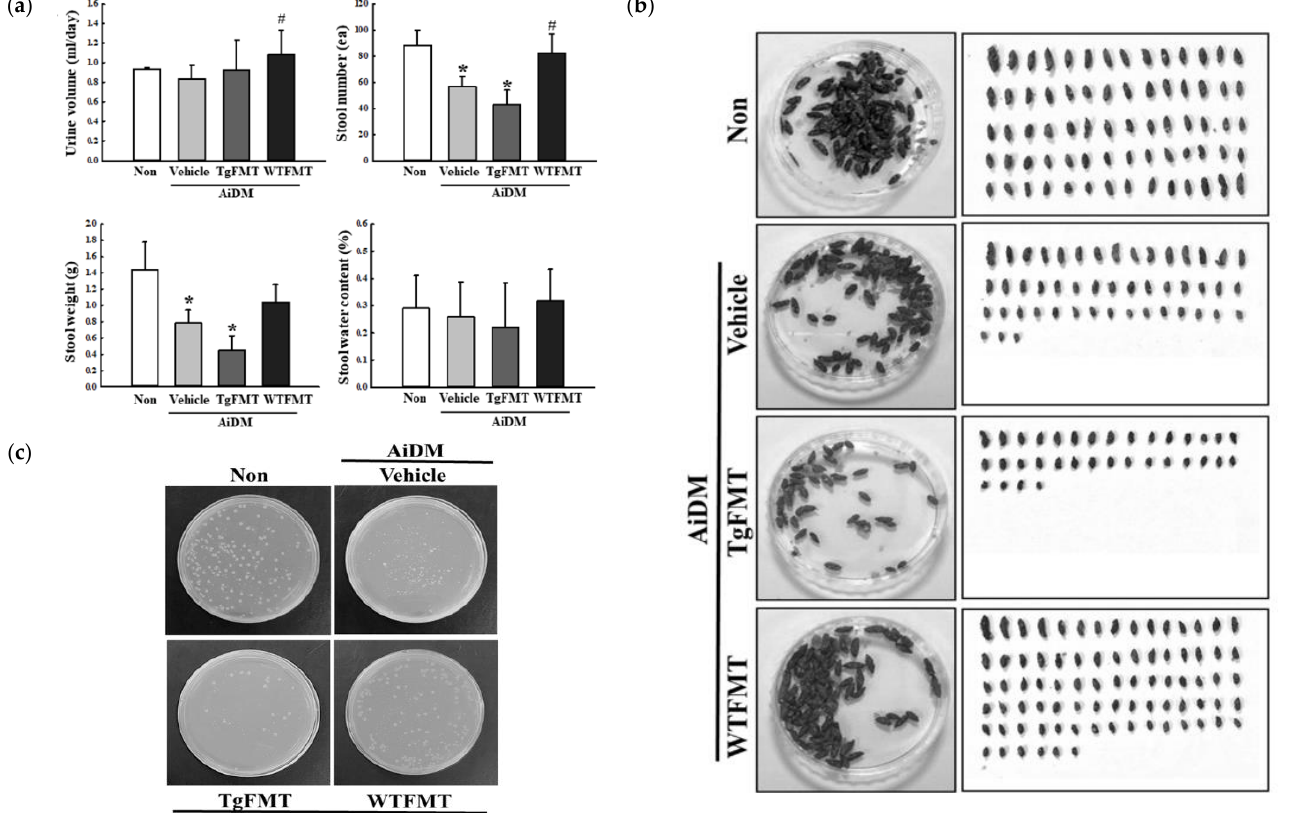
Figure 5. Excretion parameters and growth of feces-derived bacteria in AiDM+TgFMT mice. ( a ) Excretion parameters. The urine volume, stool number, stool weight, and stool water contents were measured, as described in Materials and Methods. ( b ) Stool morphological characteristics. After collecting stools from a metabolic cage, they were arranged according to size, and digital camera images were taken immediately. ( c ) Cultivation of feces-derived bacteria. The growth pattern of bacteria colonies was observed and analyzed on a view box. The stool collection was prepared from three to five mice per group, and each stool parameter was analyzed in duplicate. The data are reported as the mean ± SD values. *, p < 0.05 compared to the Non-treated group. #, p < 0.05 compared to the AiDM+Vehicle